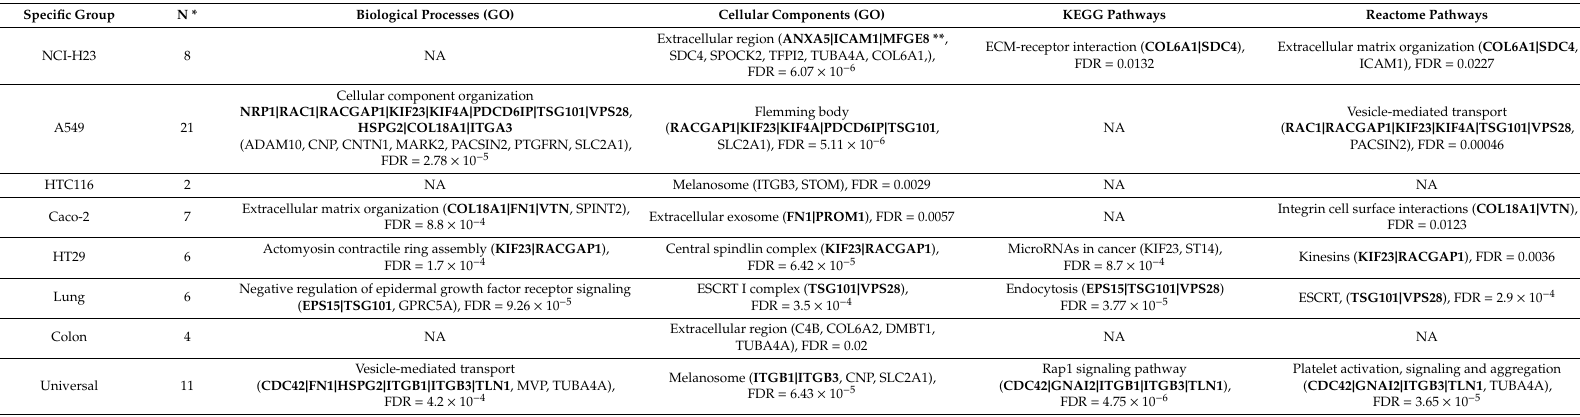
Table 3. Summary of EV protein markers annotated against their Biological Processes (GO), KEGG Pathways, Reactome Pathways, and Cellular Components (GO).